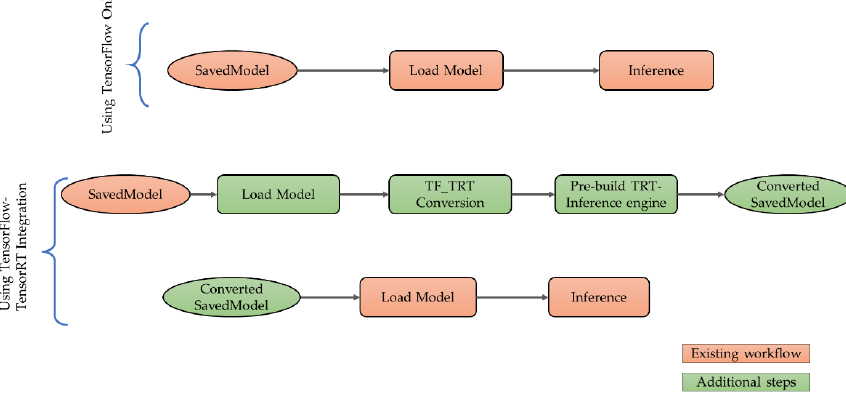
Figure 10. Inferencing procedure in Nvidia Jetson TX2 in which additional steps (green) were em-